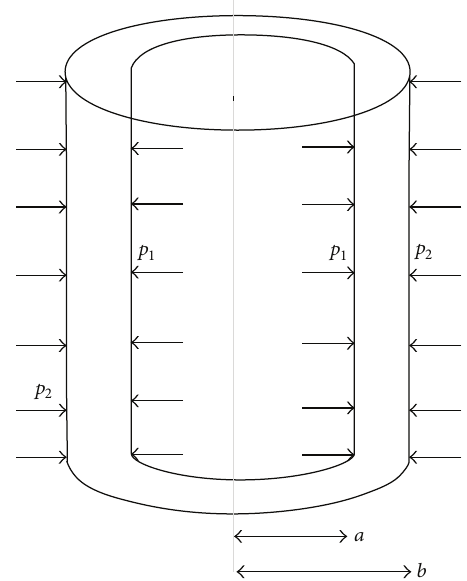
Figure 1: Geometry of thick-walled transversely isotropic cylinder under internal and external